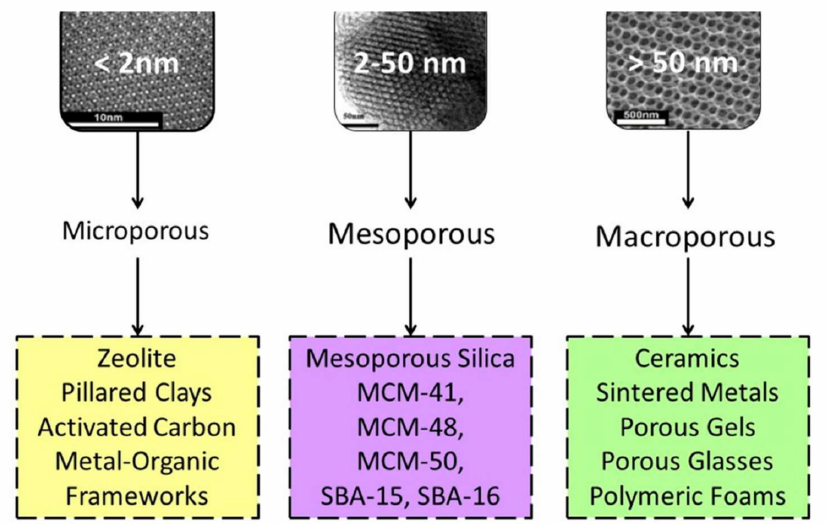
Figure 2. IUPAC classification of NMs in the three indicated classes in the function of their porosity MCM-41, MCM-48, MCM50, SBA-15, and SBA-16 are special types of organized mesoporous silicate systems [10]. Image created with